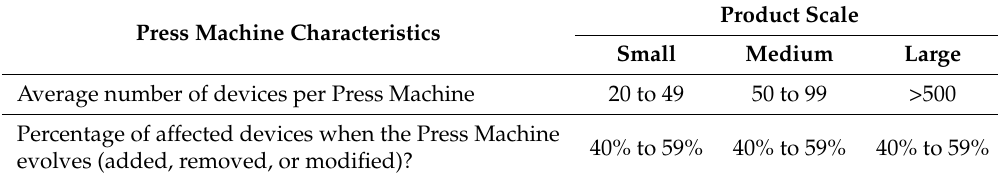
Table 1. The characteristics of a Press